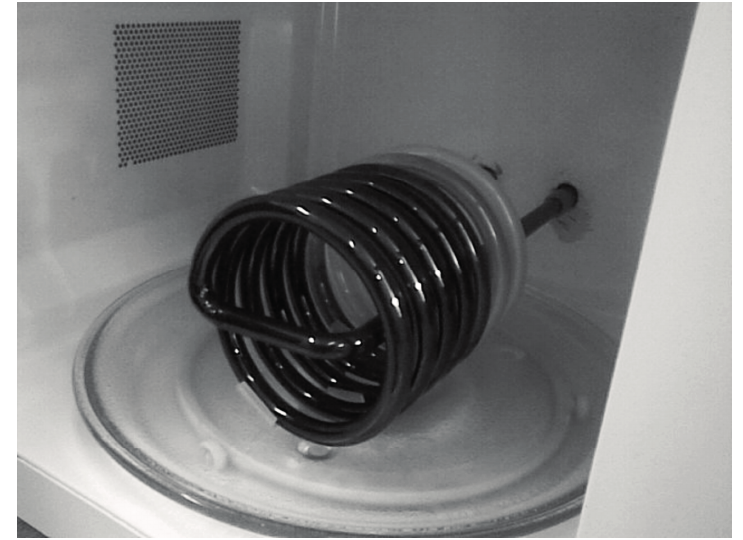
Figure 3. The view of microwave reactor